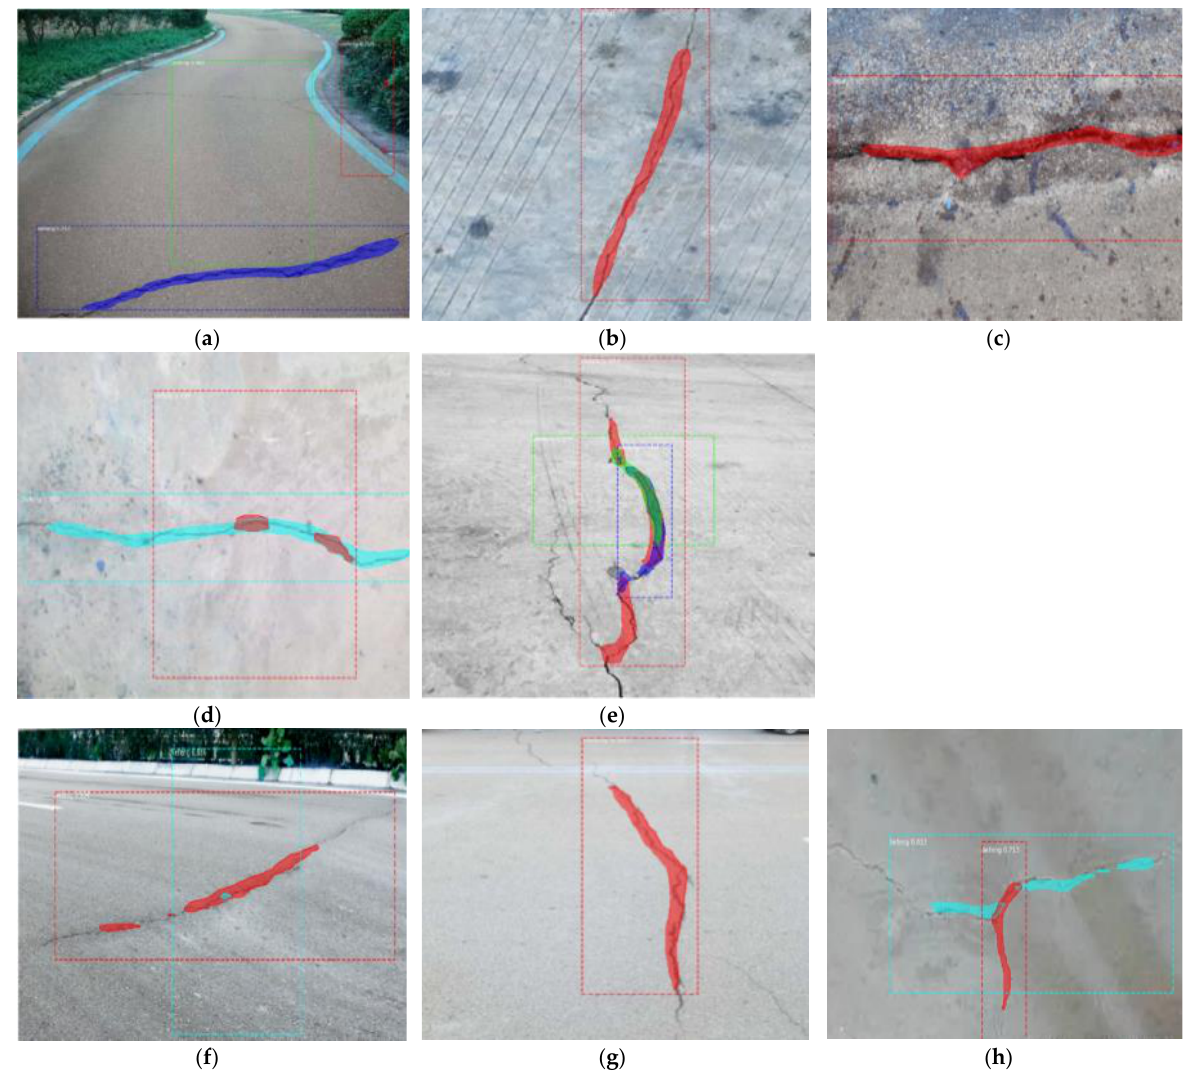
Figure 6. Recognition results of pavement cracks. ( a ) Confidence level: 75.1%; ( b ) Confidence level: 91.1%; ( c ) Confidence level: 75.1%; ( d ) Confidence level: 88.5%; ( e ) Confidence level: 90.0%; ( f ) Confidence level: 72.5%; ( g ) Confidence level: 87.7%; ( h ) Confidence level: 86.9%.